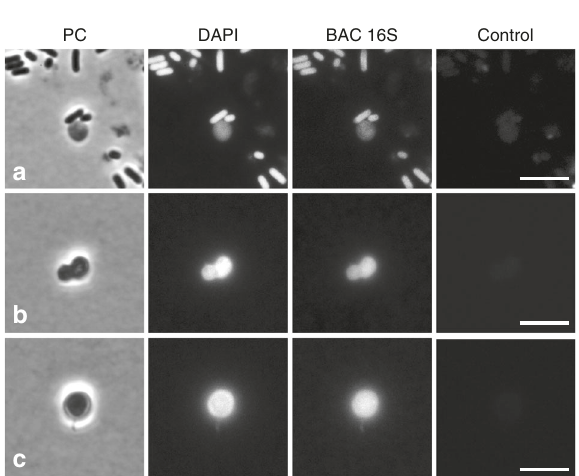
Fig. 3 Examples of L-form-like structures observed in the patient UTI343 urine. a – c Example images taken before ( a ) and during ( b , c ) the treatment with phosphomycin, assessed by phase contrast and FISH. Scale bar = 5